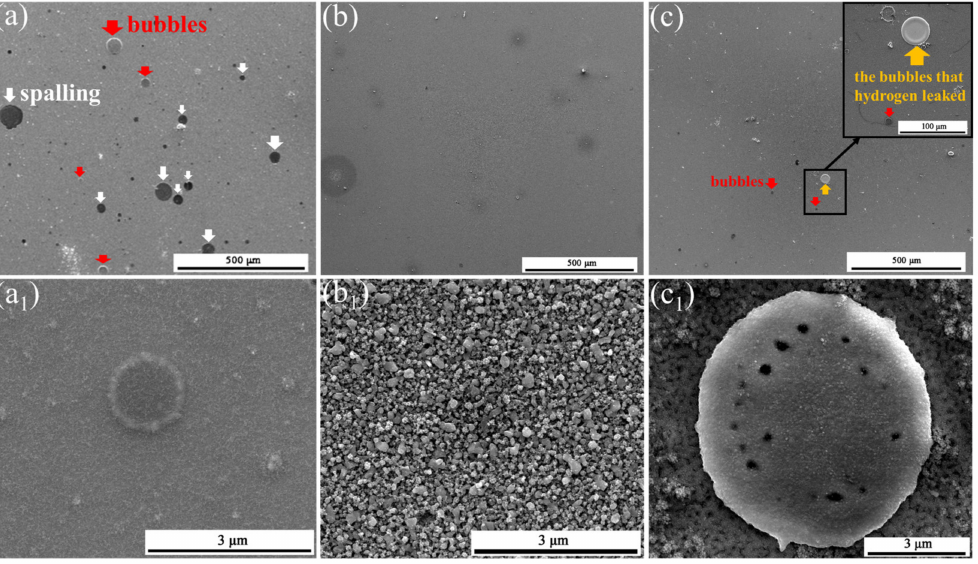
Figure 11. Surface SEM images of specimens irradiated with fluence of 3.9 × 10 22 cm − 2 hydrogen ions: ( a , a 1 ) Cr 20 Mn 17 Fe 18 Ta 23 W 22 ; ( b , b 1 ) HT1 (Ar:O 2 = 1:1) and ( c , c 1 ) HT3 (Ar:O 2 =